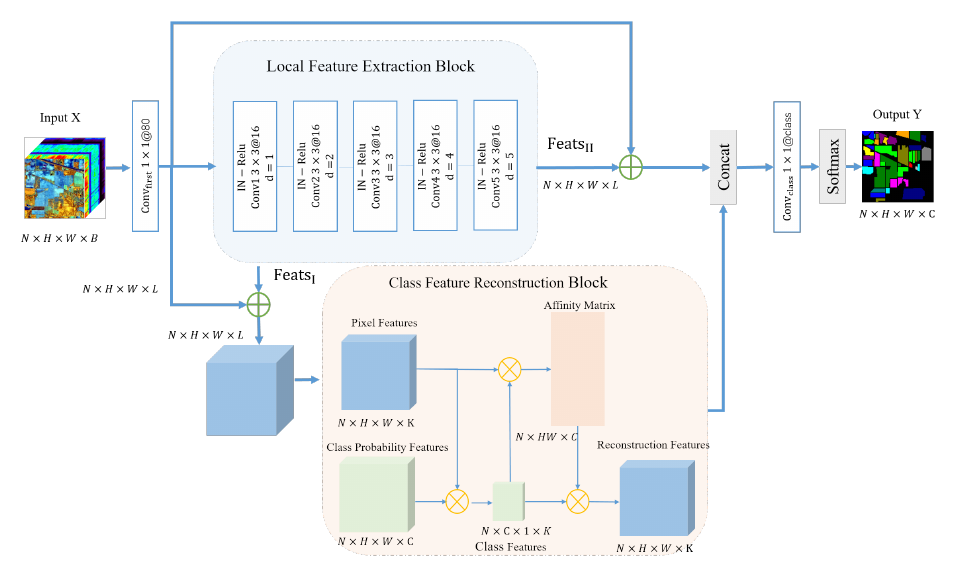
Figure 3. An overview of the proposed CFF-FCN.